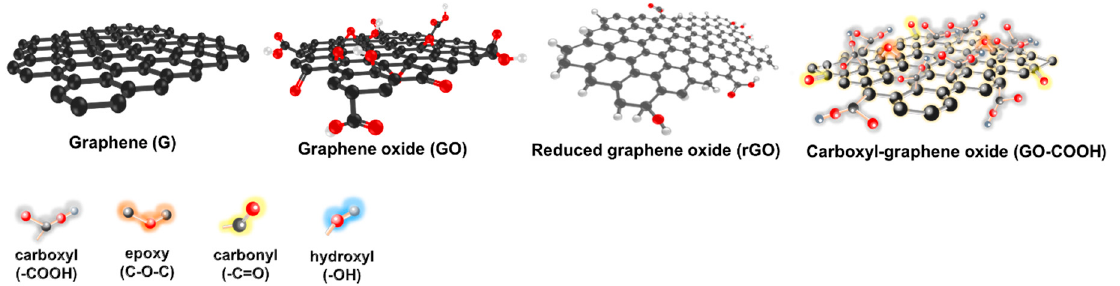
Figure 1. Graphene and its derivatives.